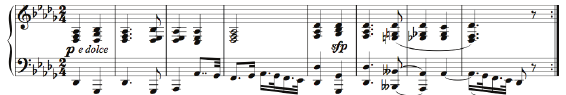
Figure 3 Beethoven, Sonata op. 57.